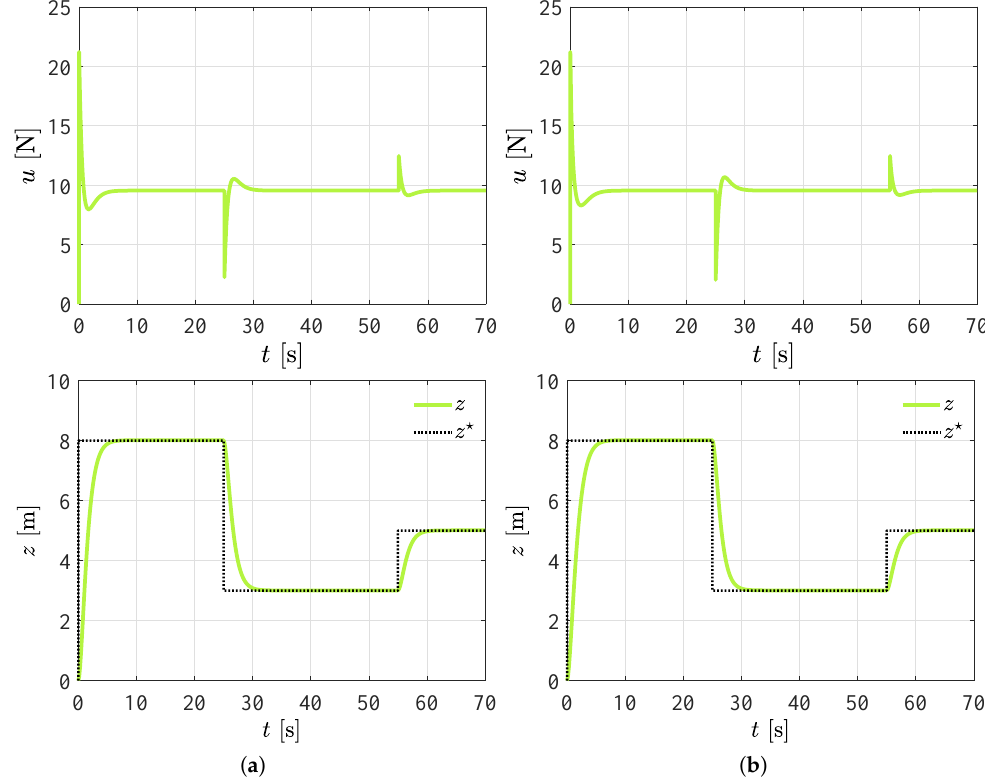
Figure 12. Tracking motion for experiment 3: ( a ) First scenario. ( b ) Second scenario. Table 4. Computed ISCI in experiment